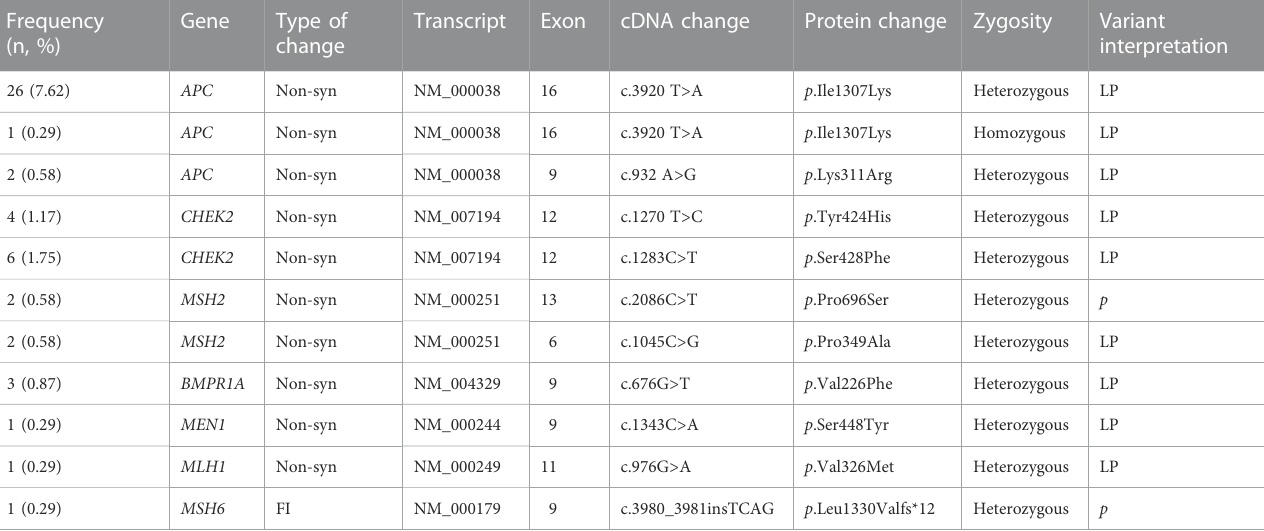
TABLE 2 Pathogenic and likely pathogenic alterations in high-risk genes detected in 341 participants. Frequency (n,